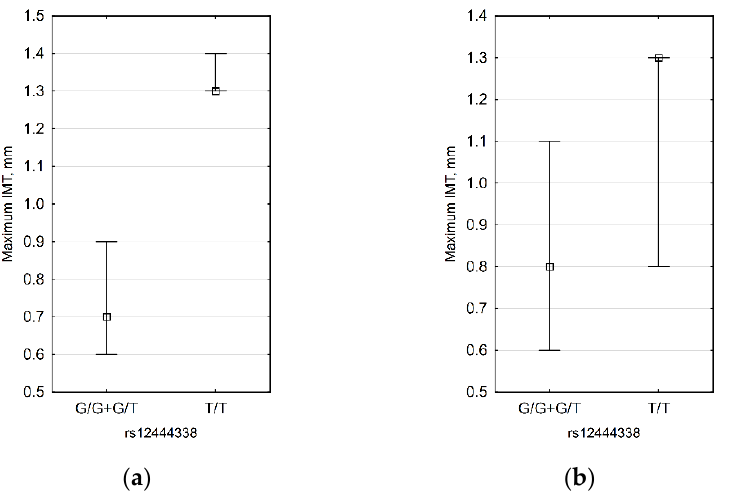
Figure 4. Significant differences in IMT between rs12444338 G allele carriers and non-carriers: ( a ) obese patients ( n = 10, p = 0.020) and ( b ) females ( n = 25, p = 0.047). Our data show that plasma T-cadherin levels are lower in G/G subjects (Figure 5). Median T-cadherin plasma level in these subjects is 3.25 (2.67; 3.70) µg/L, while in other genotypes this level is 4.061 (3.62; 5.07) µg/L ( p = 0.018).